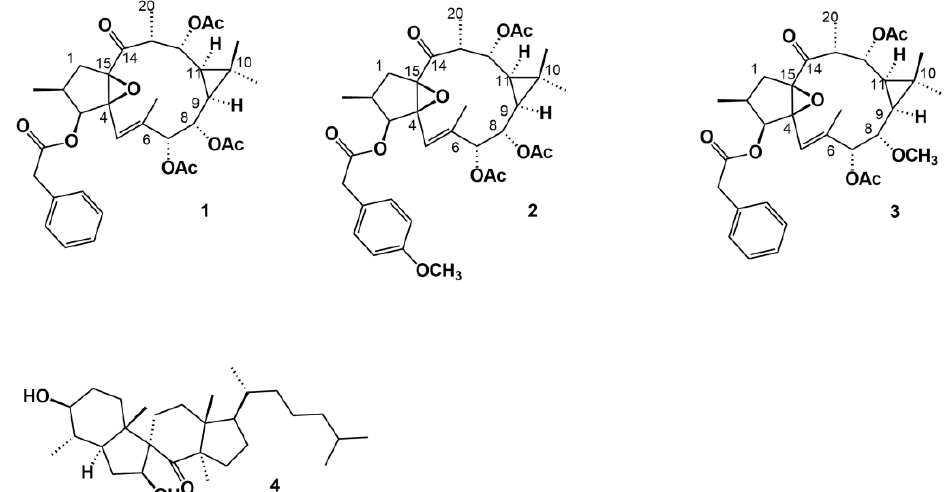
Figure 4. Phenylacetylingol derivatives ( 1 - 3 ) and spirotriterpenoid ( 4 ) isolated from the methanolic extract of E. officinarum latex .